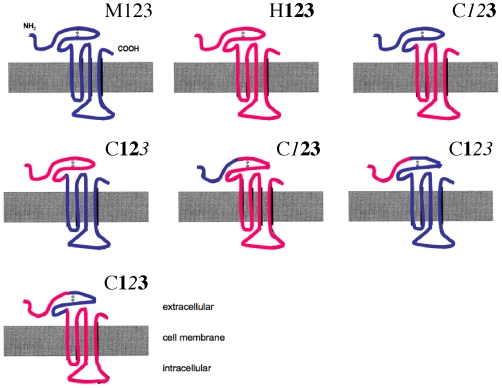
Different receptor chimeras and the respective sequences consisting of human and mouse 5-HT3A receptor composites.For clarity, human, murine receptors and chimeras are indicated as a combination of the numbers for the three different sequences, where human sequences are marked in bold and murine sequences are marked in italics. The prefix “H”, “M” and “C” indicates human, murine and chimeric receptors, respectively: human 5-HT3 receptor = H123, murine 5-HT3 receptor = M123, chimeric receptors are C123, C123, SH1,C123, C123 and C123.